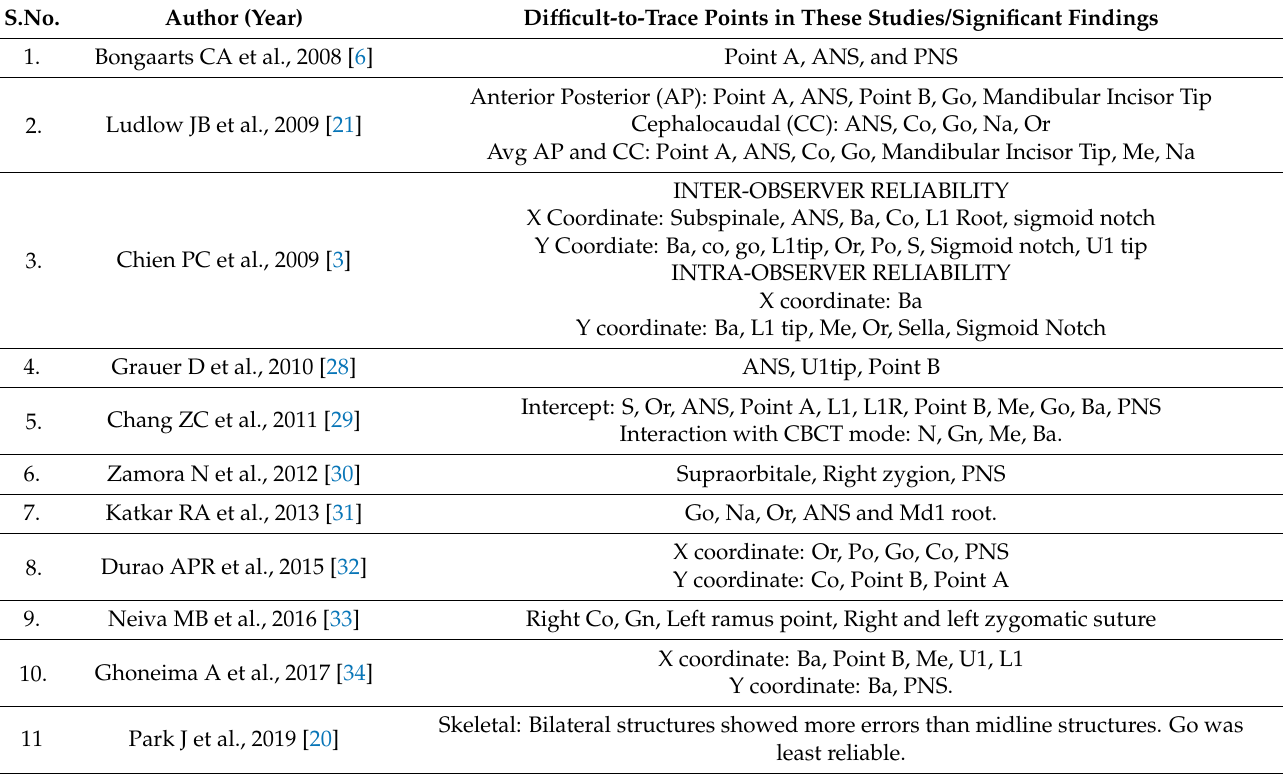
Table 2. Studies reviewed to determine difficult-to-trace